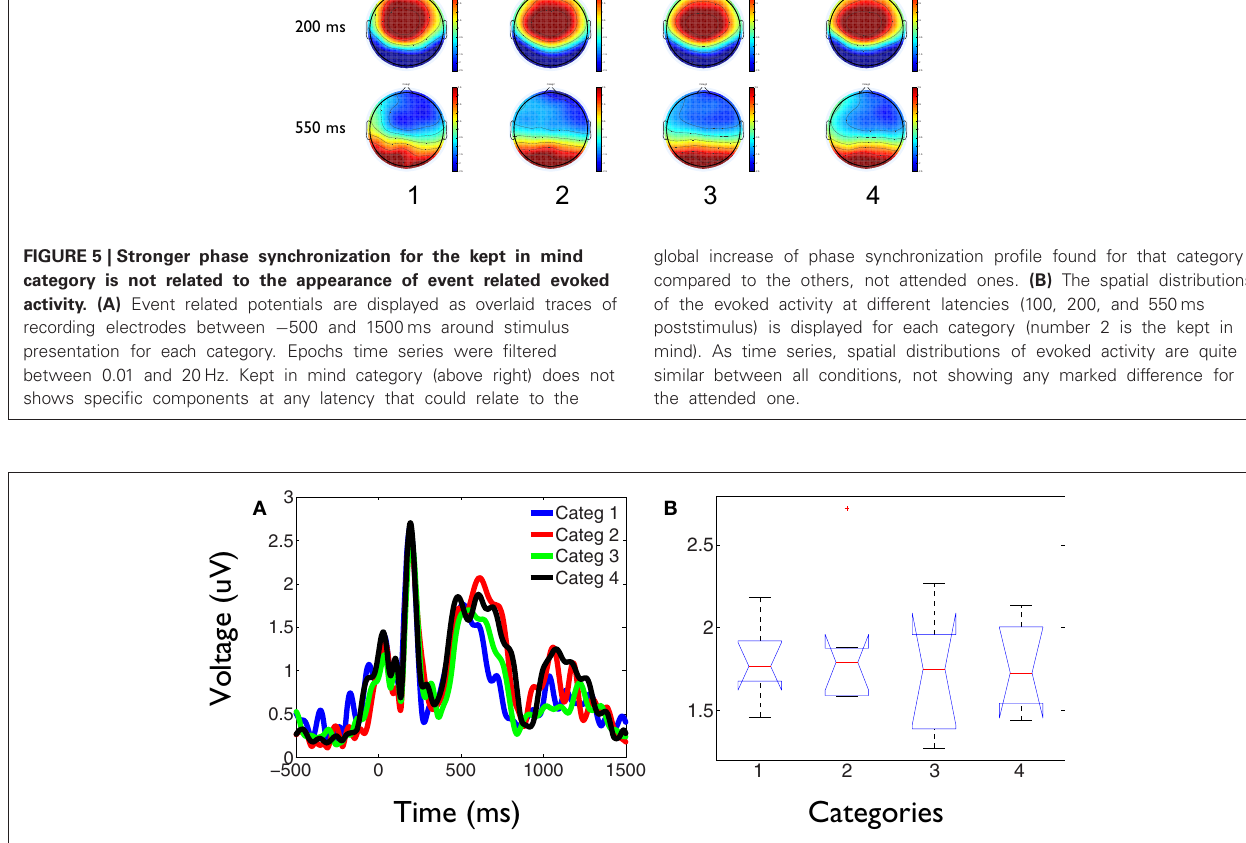
(B) Example box and whisker plots of the average activity across subjects in the time interval between 500 and 600ms poststimulus, when prominent differences were found in the profile of global phase synchronization between conditions. No significant differences were obtained between category 2 and the other categories at any latency across the